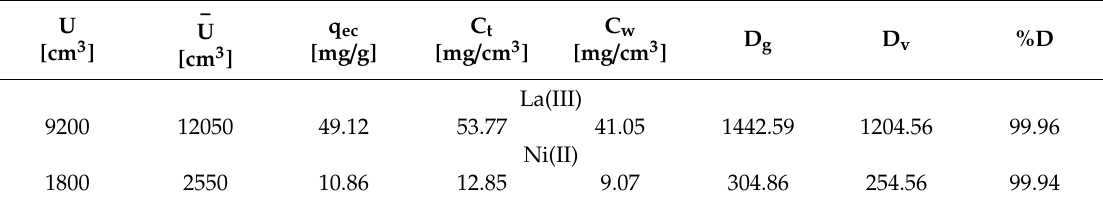
Table 6. Dynamic studies parameters of lanthanum(III) and nickel(II) ions sorption (C 0 = 50 mg / dm 3 , pH = 1.5).